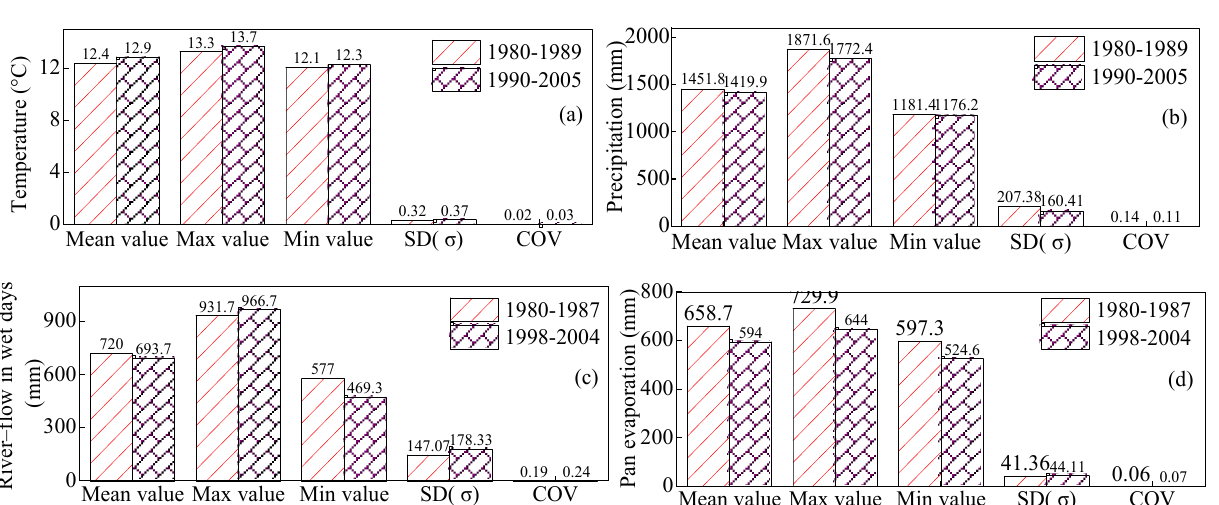
Table 5. Statics for seasonal variability of precipitation (P), runoff (R), evapotranspiration plus change in storage (ETDS), and water yield (WY) for Cub watershed (Data source; [133]). Time